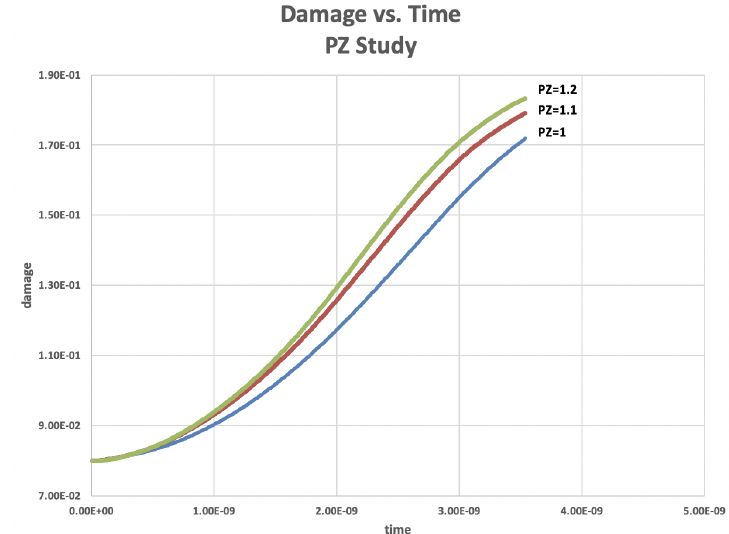
Figure 6. The ensemble-averaged damage is plotted as a function of time for an imposed strain rate ˙ ϵ = 1 × 10 5 s − 1 . The three curves represent process zone sizes of 0%, 10% and 20% of the crack radius. The ensemble size is 100. A larger process zone implies slightly more damage at time of